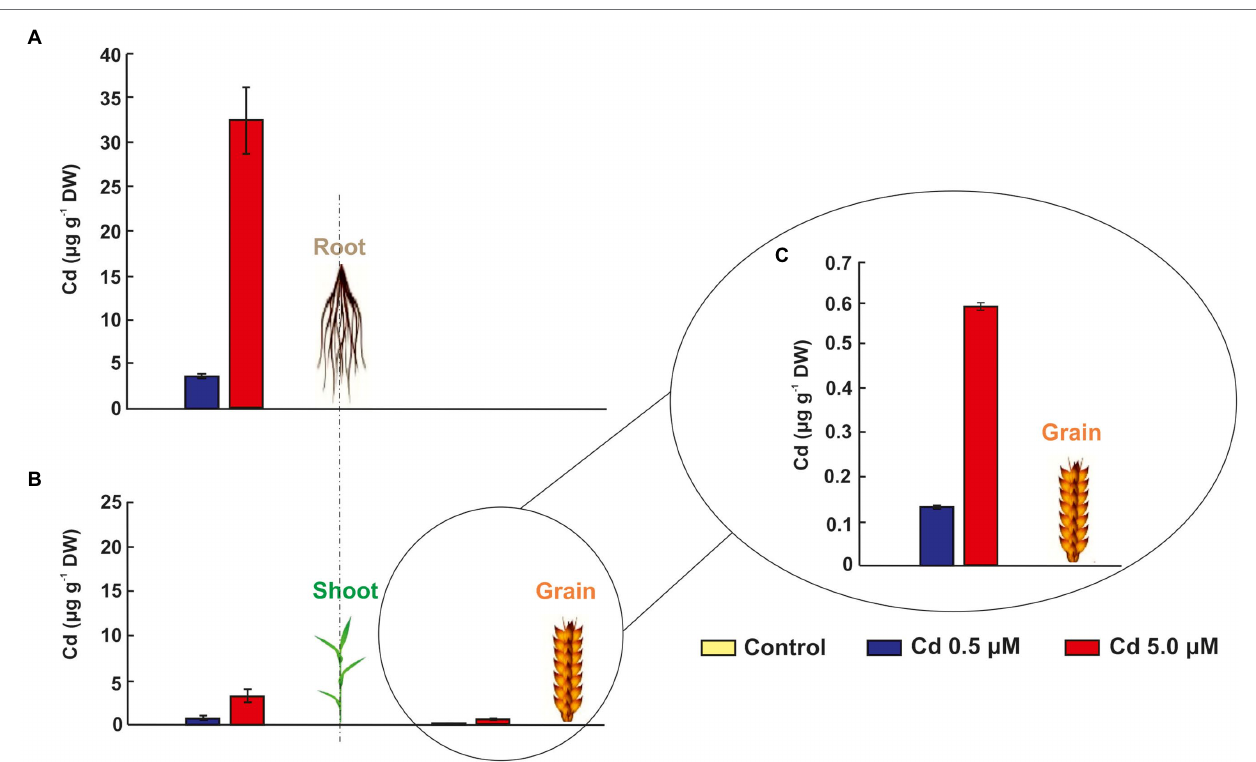
FIGURE 3 | Cadmium in grains, shoots and roots of seedlings grown for 15 days (starting from sprouting) in control conditions and in the presence of Cd 0.5 and 5.0 μ M. Panels (A) and (B) Cd concentrations in μ g/g DW (dry weight) of grains, shoots and roots. To appreciate the differences between the two treatments (Cd 0.5 and 5.0 μ M) in grains, a third panel was added: panel (C) data of Cd concentration in